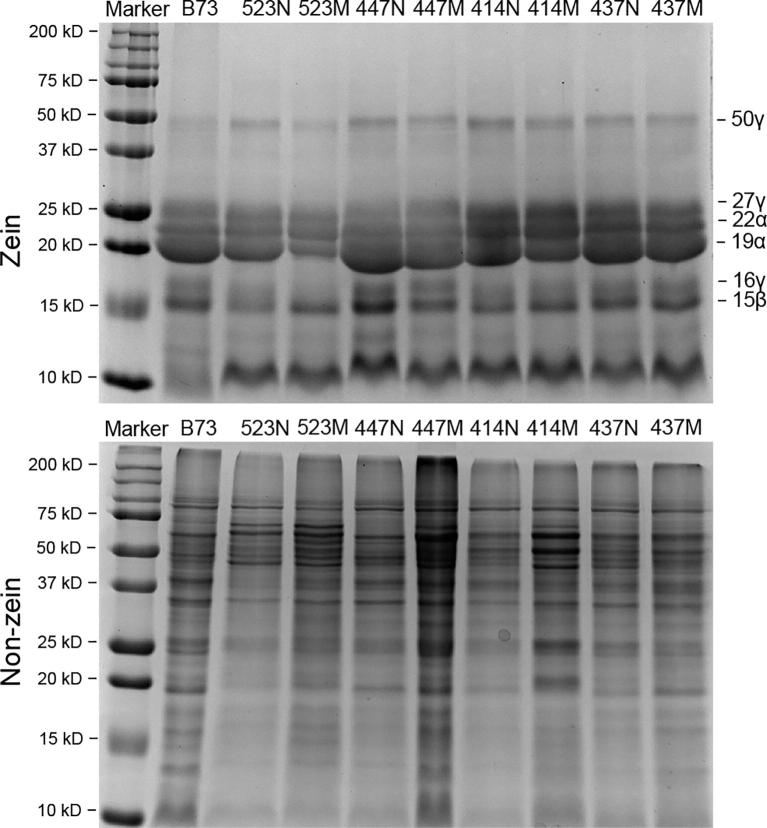
Zein and non-zein protein profiles in opaque mutants Normal and mutant kernels from F2 ears with segregation were used for zein and non-zein extraction.